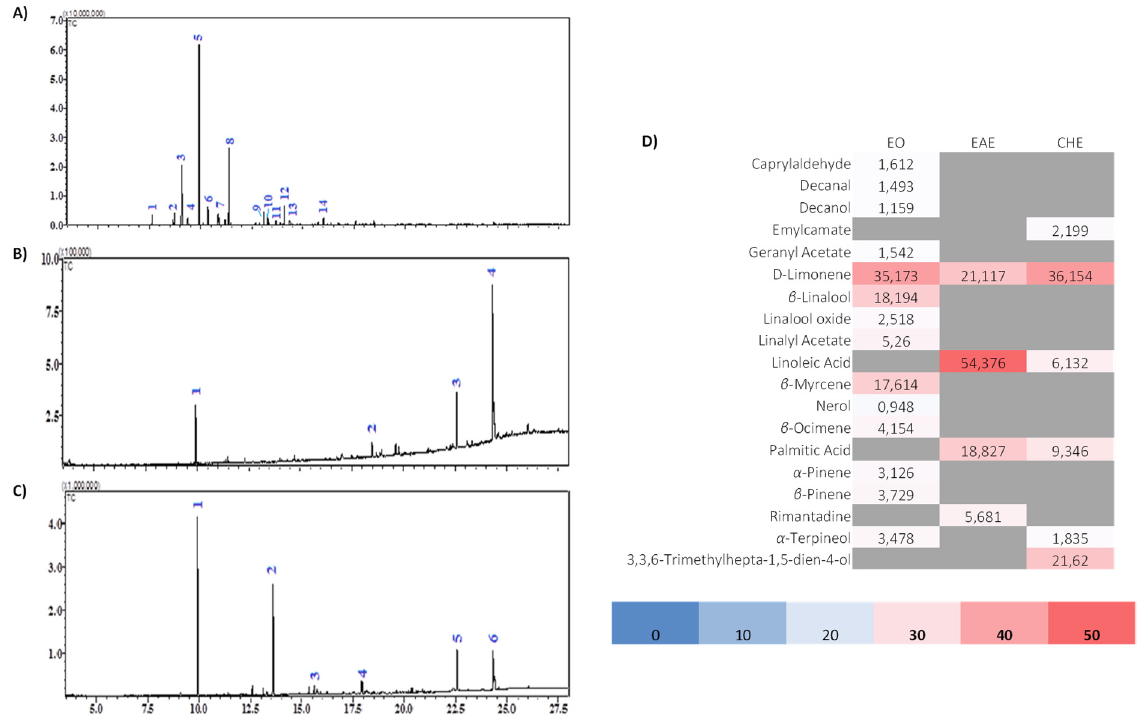
Figure 3. GC-MS chromatogram of the extracts from the peel of C. aurantium L.: ( A ) essential oil (EO), ( B ) ethyl acetate, ( C ) cyclohexane, and ( D ) relative quantification (%) of individual compounds identified in each extract. For numbers ap- pearing in ( A ), ( B ) and ( C ): please refer to Tables S1–S3 respectively.